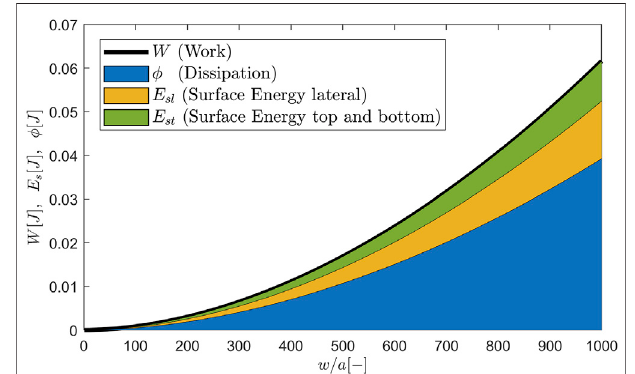
FIGURE 9 | Energy balance showing how the width of the model w / a (horizontal axis) in fl uences the applied work (thick black line), and how this workissplitintoenergydissipation(blue),surfaceenergyassociatedtothetop andbottomsurfaces(green)andsurfaceenergyassociatedtothelateral surfaces